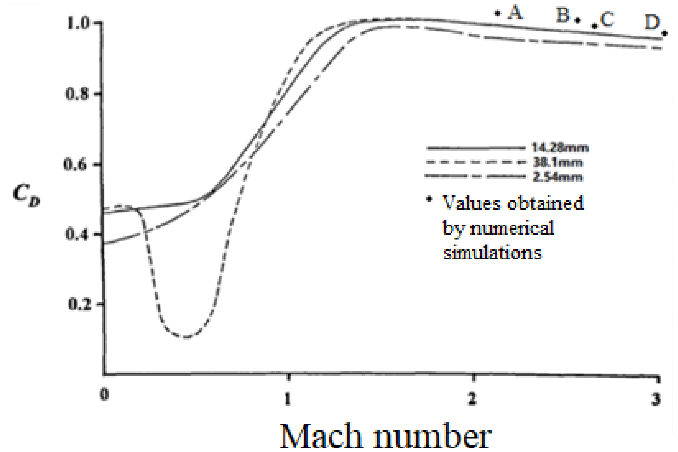
Figure 3. Drag coefficient as a function of Mach number for spheres with different